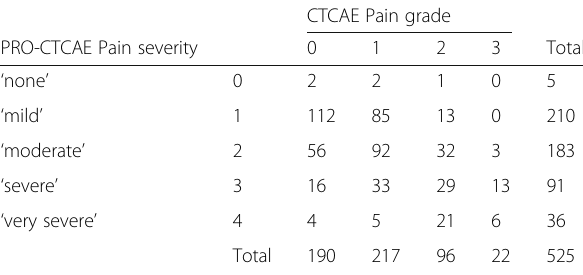
Table 4 Example of cross-tabulation of CTCAE pain grades and PRO-CTCAE pain severity ratings ( n = 525) CTCAE Pain grade PRO-CTCAE Pain severity